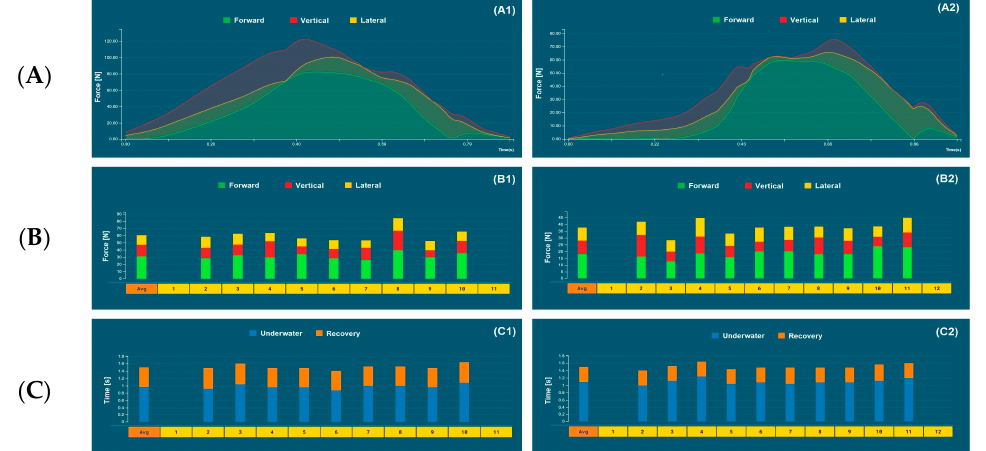
Figure 3. Example of data that can be analyzed in the Analysis Center. Suffixes 1 and 2 correspond to the left and right hand, respectively. Panels ( A )—amount and force direction of the average arm-pull. Panels ( B )—amount of force by arm-pull. Panels ( C )—time spent in each arm-pull (underwater phase) and in recovery (aerial phase).